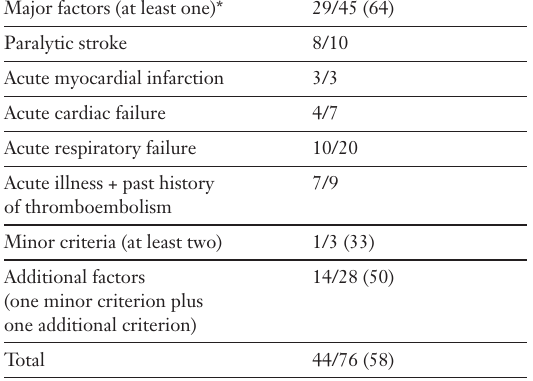
Explicit criteria and appropriateness of thromboprophylaxis.